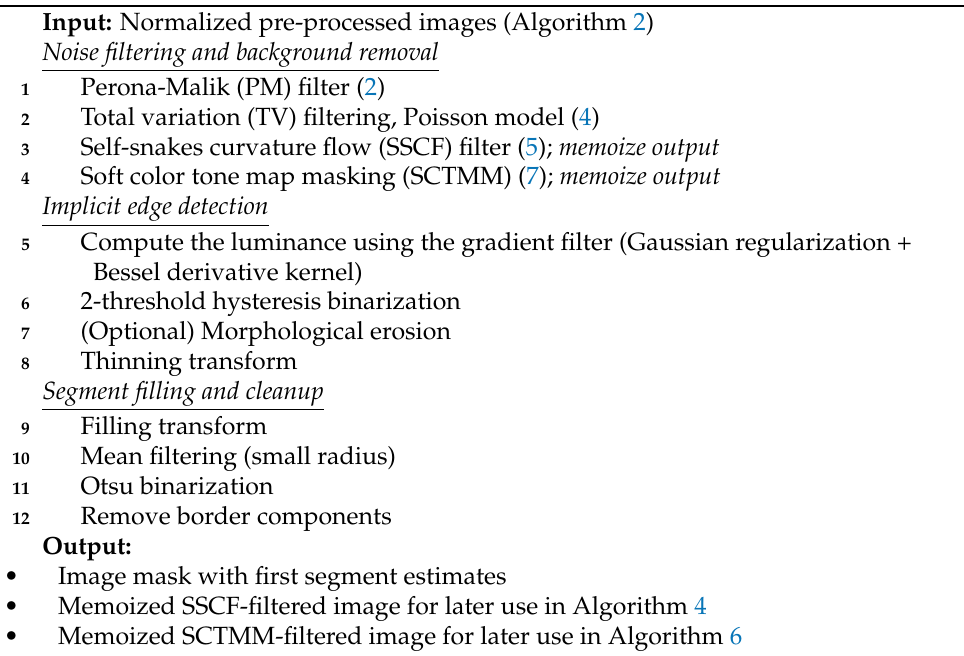
Algorithm 3: Global first segment estimator for pre-processed FOV